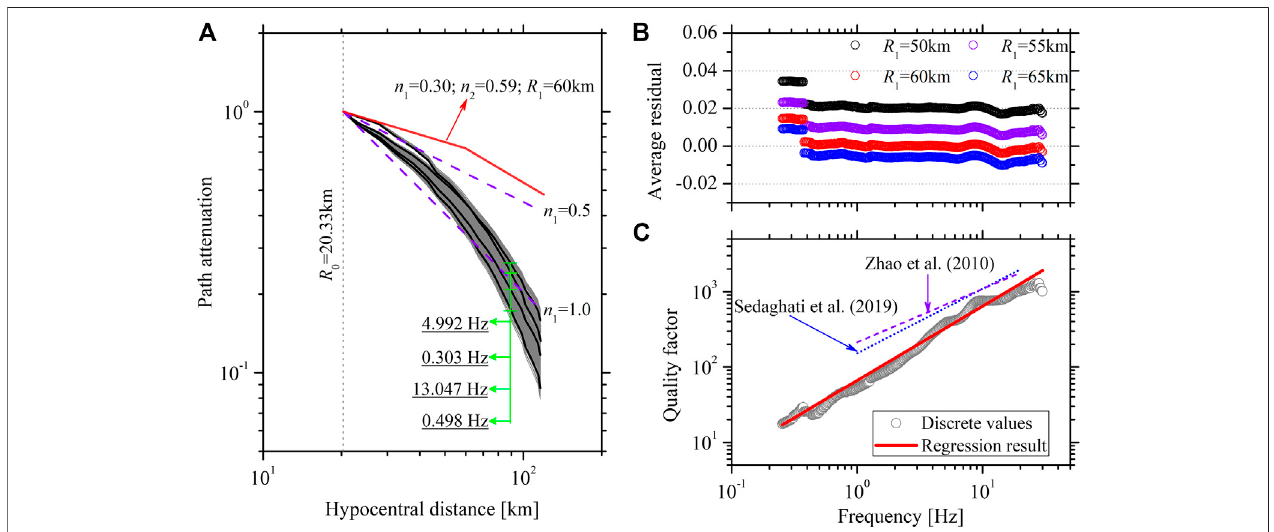
FIGURE 5 | (A) The path attenuation curves derived for frequencies at 0.254 – 30 Hz. The hinged bilinear geometrical spreading model with the transition distance R 1 (cid:1) 60 kmprovidedinthisstudyisplottedandcomparedwiththegeometricalspreadingmodelsexpressedas( R 0 / R ) 0.5 and( R 0 / R ) 1.0 . (B) Theaverageresidualbetween theinvertedandthemodeledpathattenuationsoveralldistancesforeachfrequencywithtransitiondistancesof R 1 (cid:1) 50,55,60,and65 km,respectively. (C) Calculated Q values(circles)andtheregressed Q model(solidline)inourstudy.The Q modelsforthenorthwestTarimBasinproposedbyZhaoetal.(2011)andtheTajikistan- Kyrgyzstan region west and northwest of our study region proposed by Sedaghati et al. (2019) are also plotted.